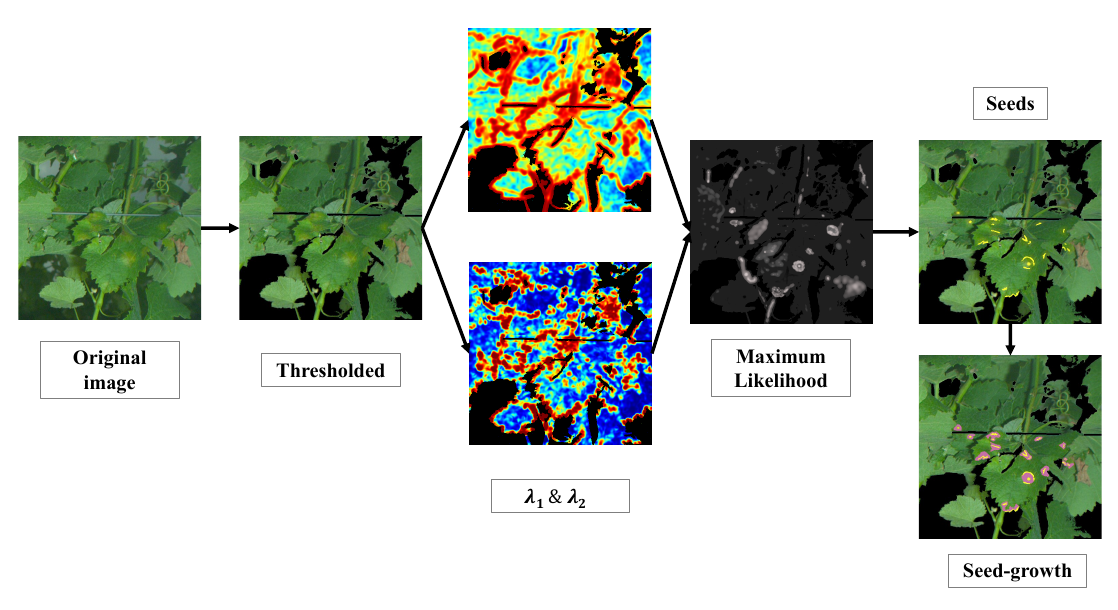
Figure 4. Graphical resume of the processing